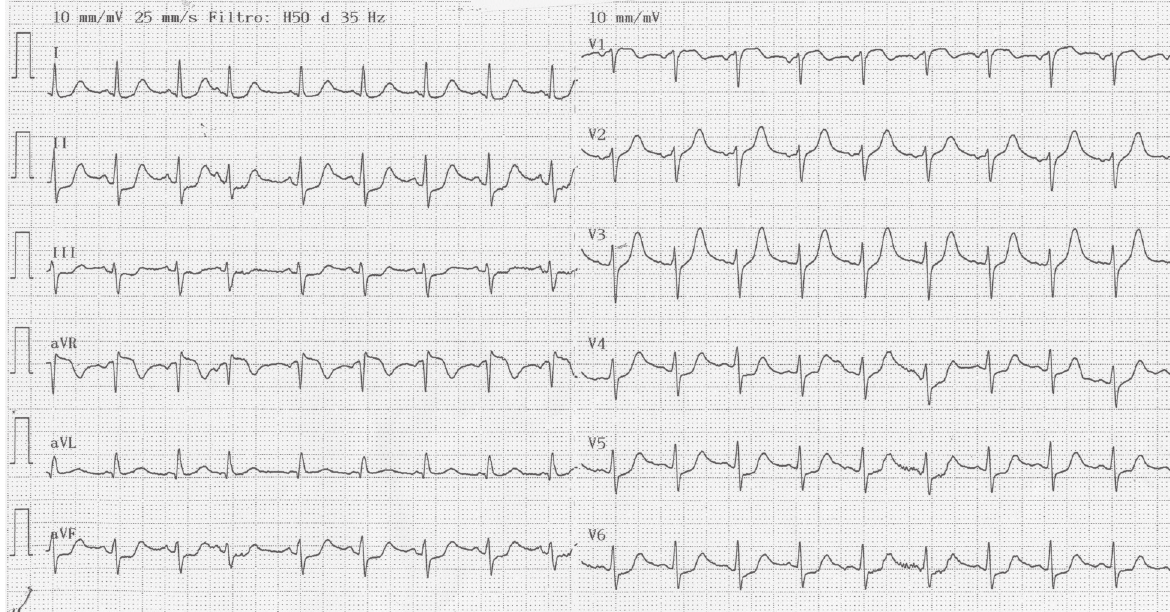
Figure 1. First electrocardiogram showing sinusal rhythm with some supraventricular ectopic beats and ST segment depression in leads II, III, aVF, and